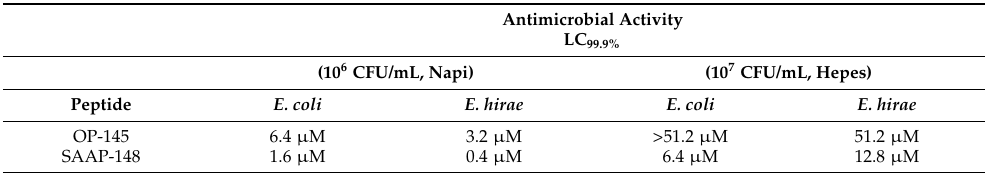
Table 1. Antimicrobial activity of OP-145 and SAAP-148 against E. coli and E. hirae . Peptides were exposed either to 1 × 10 6 CFU/mL of E. coli and E. hirae in presence of NaPi buffer or to 1 × 10 7 CFU/mL of bacteria suspended in Hepes buffer. The 99.9% lethal concentration (LC99.9%) is defined as concentration necessary to kill 99.9% of the cells. The LC 99.9% are identical in all experiments, which have been performed independently at least three times. Antimicrobial Activity LC